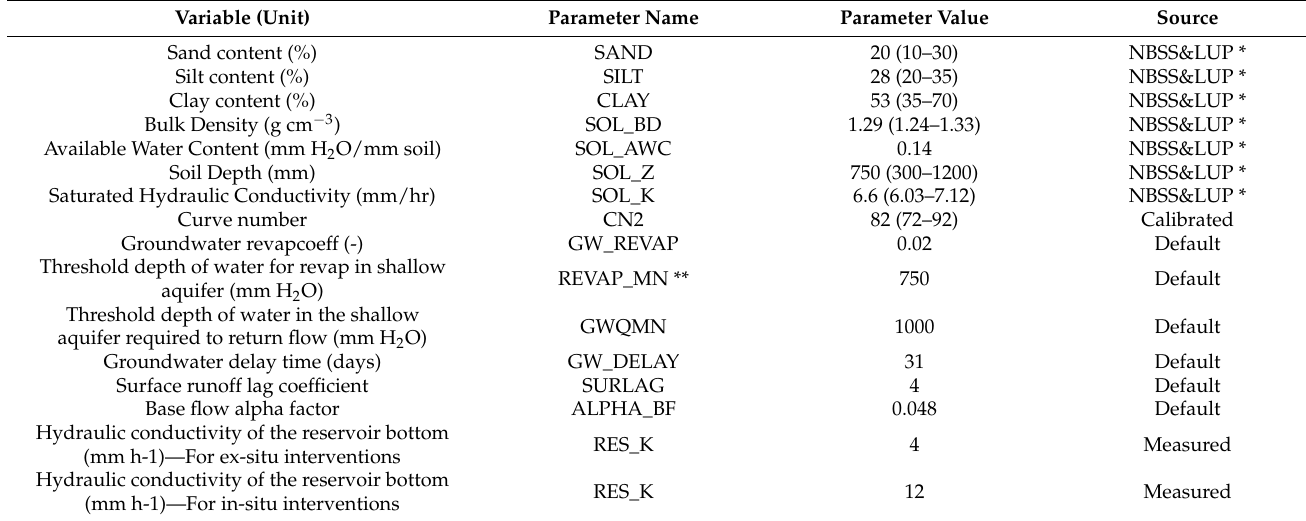
Table A3. SWAT model inputs and calibration parameters.